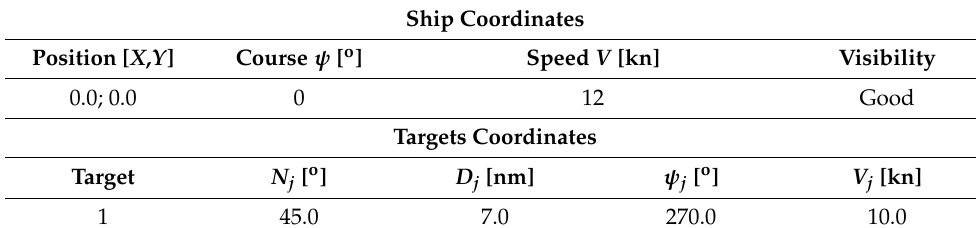
Table 4. Ship coordinates and targets coordinates (one target).